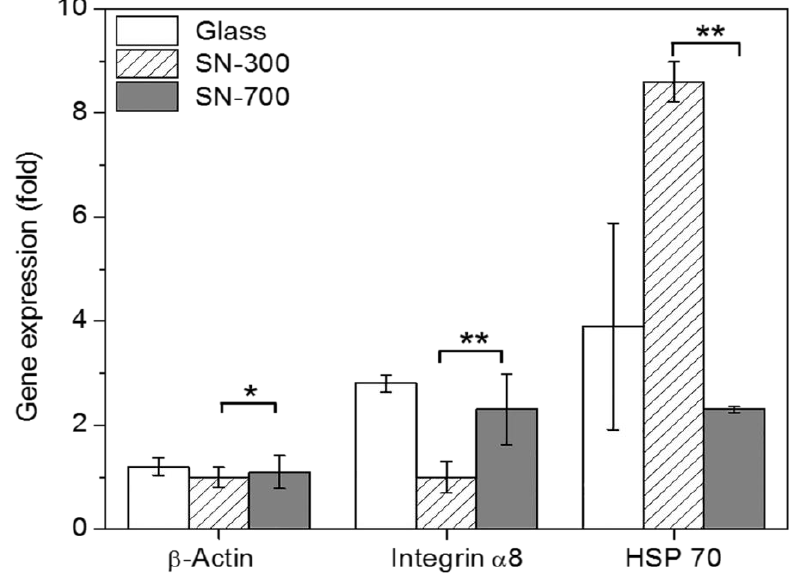
Figure 7. Analysis of β -actin, integrin α 8, and HSP 70 mRNA expression by quantitative RT-PCR. The expression values of β -actin, integrin α 8, and HSP 70 mRNA in rMDSCs grown on glass, SN-300, or SN-700 at 5 d were normalized to those of GAPDH expression of rMDSCs on glass, SN-300, or SN-700. Gene expression data were analyzed by one-way ANOVA with Bonferroni’s multiple comparison (* p < 0.05, ** p < 0.01).